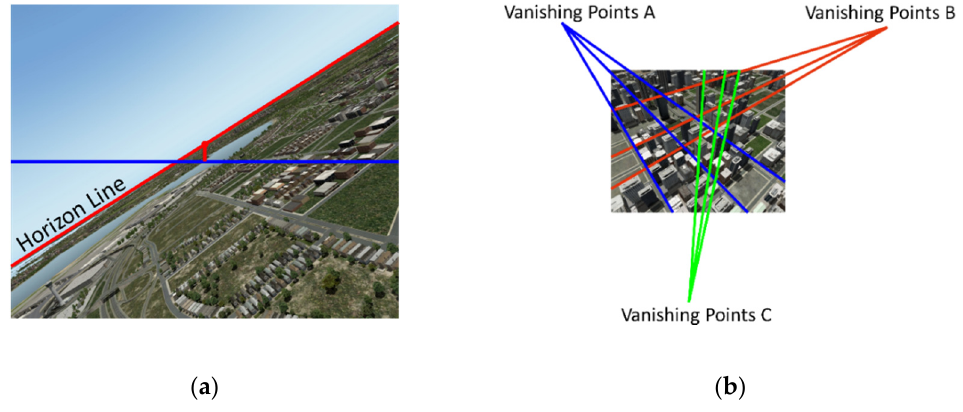
Figure 7. The attitude estimation method. ( a ) The horizon detection method. ( b ) The vanishing points method.